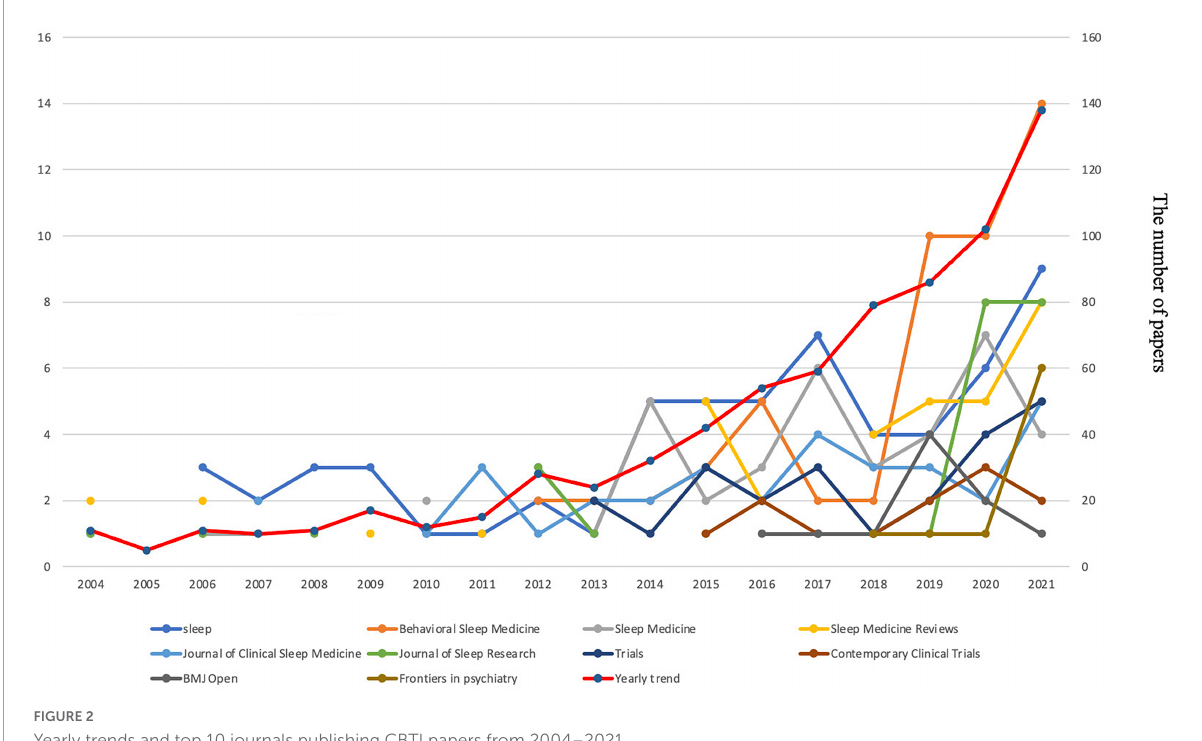
FIGURE2 Yearly trends and top 10 journals publishing CBTI papers from 2004–2021.